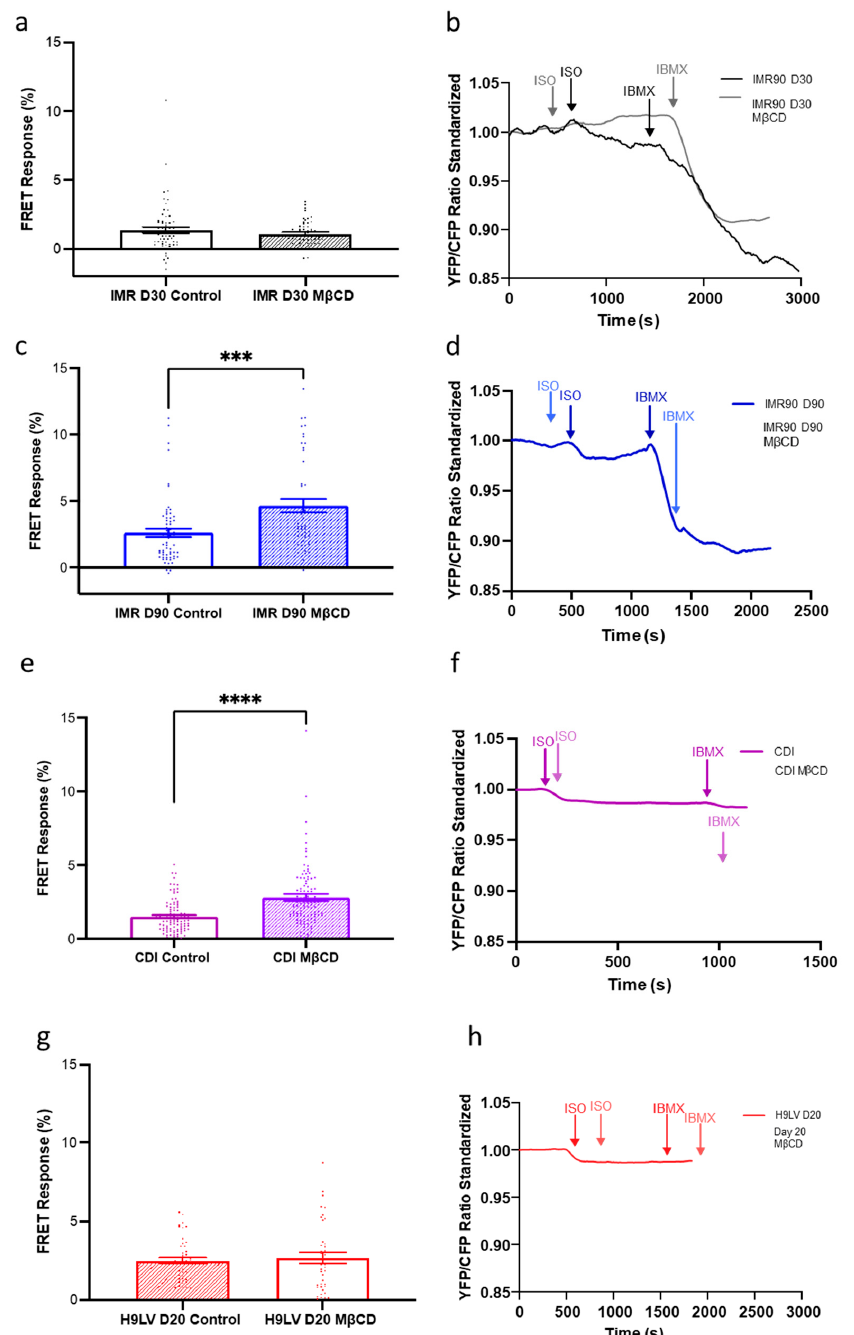
Figure 8. The effect of methyl- β -cyclodextrin (M β CD) treatment on the β 3 -adrenoreceptor (AR)- cGMP pathway in different lines of hPSC-CMs. Bar chart and model trace illustrating the effect of M β CD treatment on the cGMP production upon β 3 -AR stimulation with isoproterenol (ISO) in ( a , b ) IMR-hPSC-CMs (IMR) Day 30, ( c , d ) IMR-hPSC-CMs (IMR) Day 90, ( e , f ) CDI-hPSC-CMs (CDI)